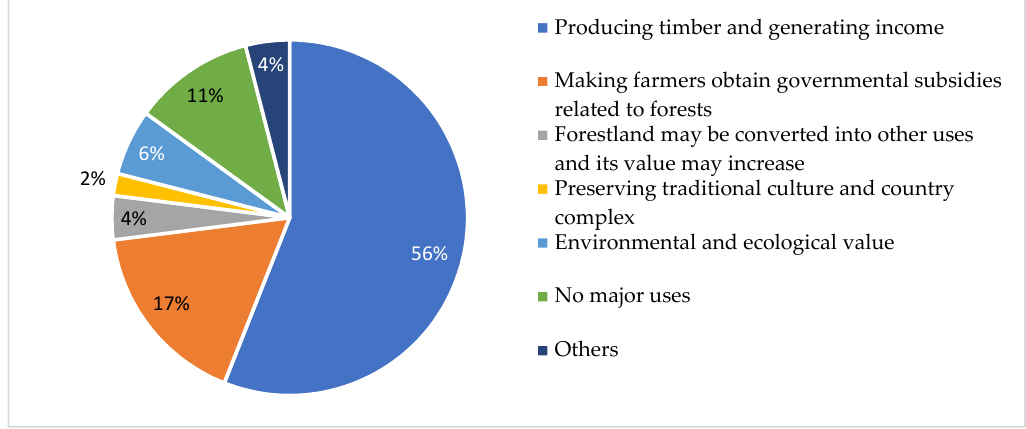
Figure 5. The perceived most important function of forests. Note: Data is from the household structured questionnaire survey (n =